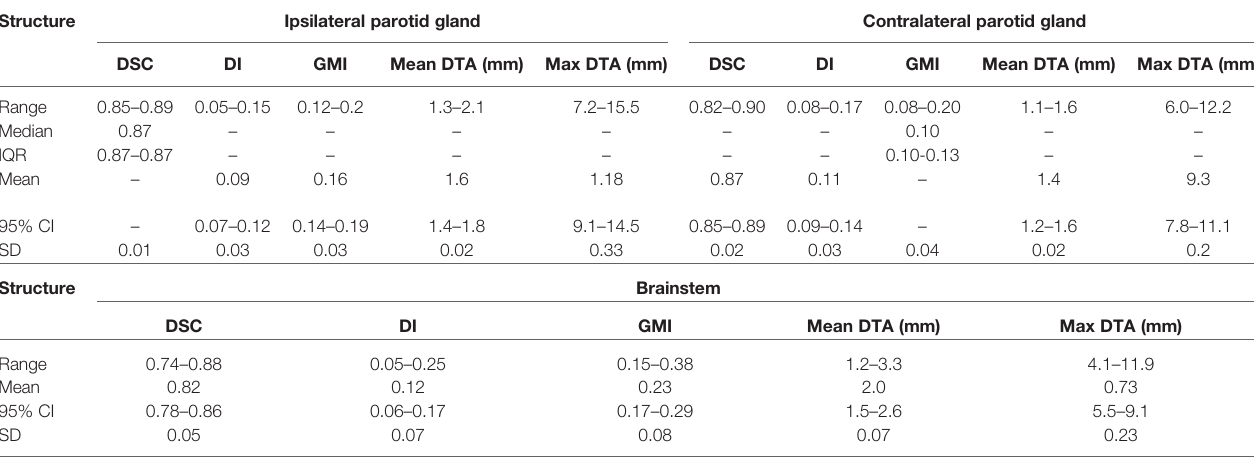
TABLE 2 | Values for different conformity indices for ipsilateral and contralateral parotid gland, and brainstem. Structure